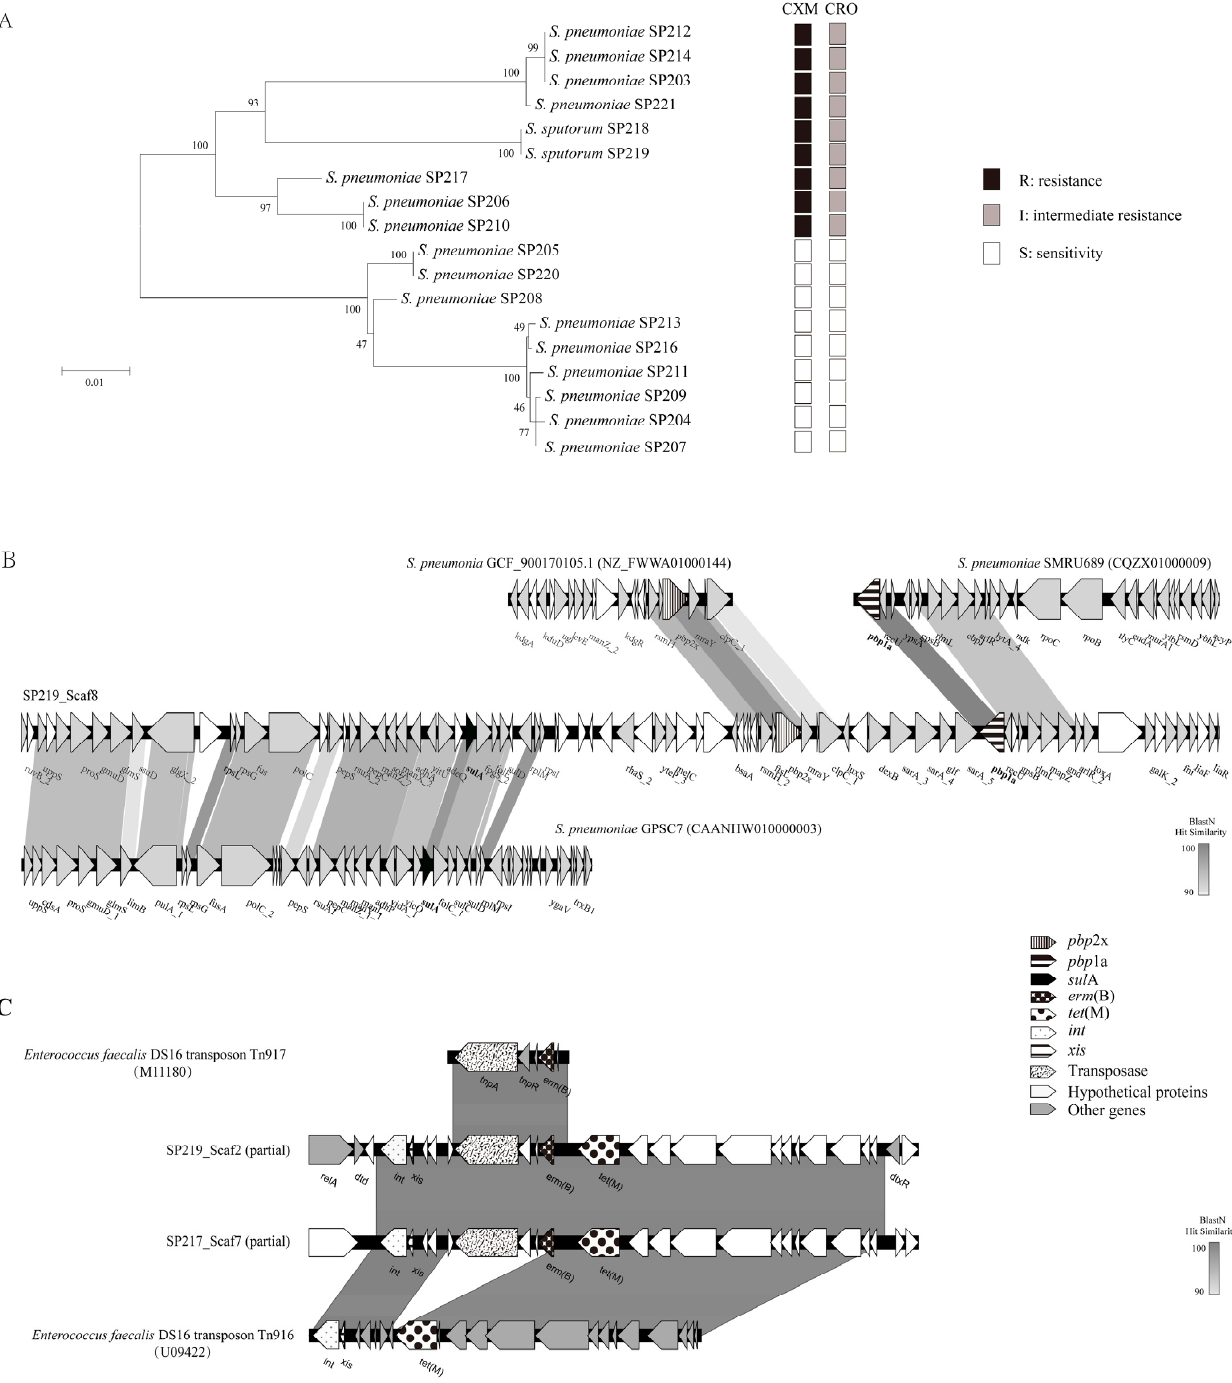
Figure 2. ( A ) Maximum-likelihood tree generated using the MEGA software based on the serial amino acid sequences of PBP1a and PBP2x from tested clinical isolates, and their cephalosporin resistance profiles. Bootstrap values of 1000 replications are shown. The bar indicates changes per amino acid position. Black squares: resistance; gray squares: intermediate resistance; white squares: sensitivity. ( B ) Genomic organization of pbp 1a-, pbp 2x-, and sul A-carrying scaffolds showing highest homology with S . pneumoniae and comparison with related sequences available in GenBank. Genes are labeled and are textured based on functional classification, as shown in the key. Gray shading represents similarity at the nucleotide level. ( C ) Genomic organization of Tn 3872 of strain S219 and S . pneumoniae SP217, and comparison with related sequences available in GenBank. Genes are labeled and are textured based on functional classification, as shown in the key. Gray shading represents similarity at the nucleotide level.